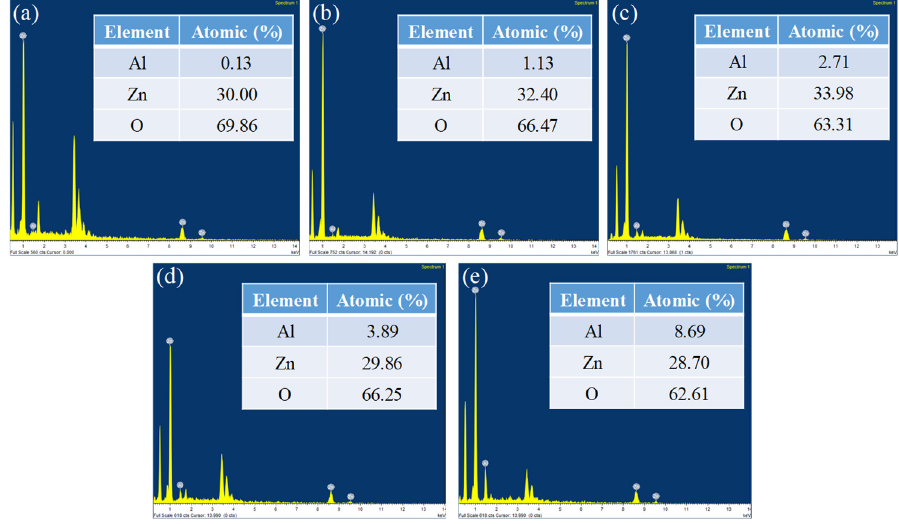
Figure 7. EDS spectrum analysis of ( a ) Pure AZO, ( b ) AZO with 10 nm of Al, ( c ) AZO with 20 nm of Al, ( d ) AZO with 40 nm of Al, ( e ) AZO with 80 nm of Al.